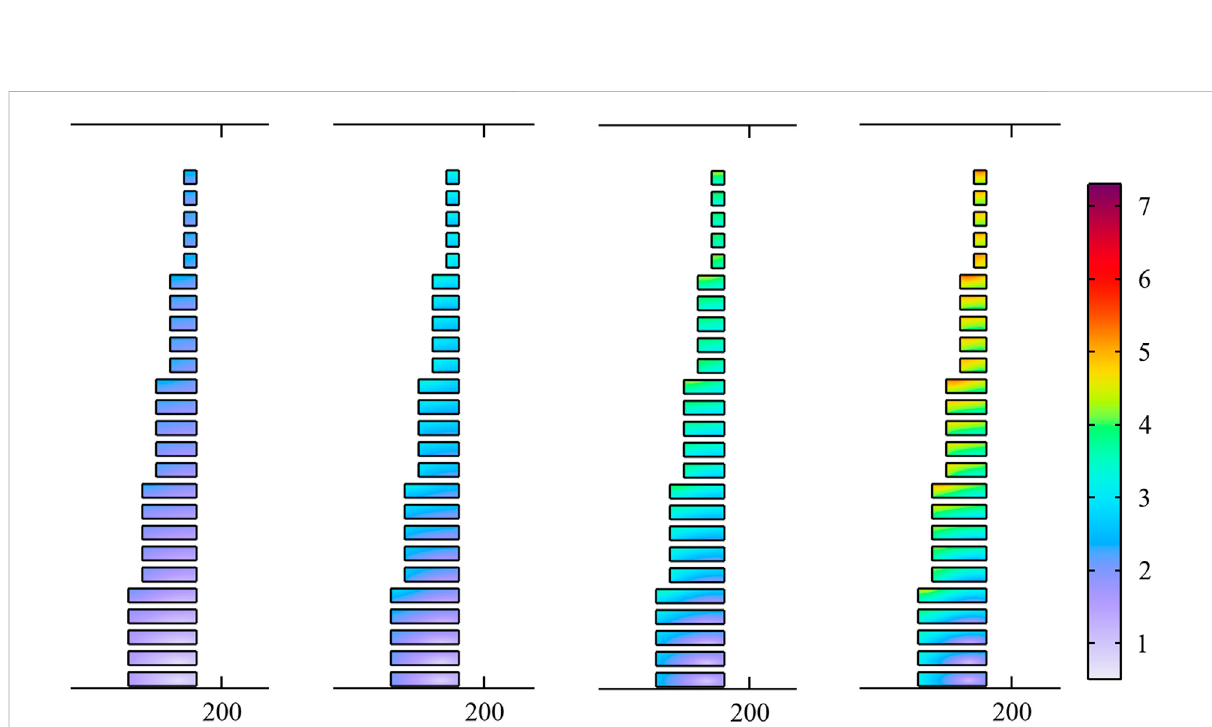
FIGURE 7 The J / J c distribution of solenoid magnet with trapezoidal cross-section while the carried current is 100, 120, 140 and 160 A.